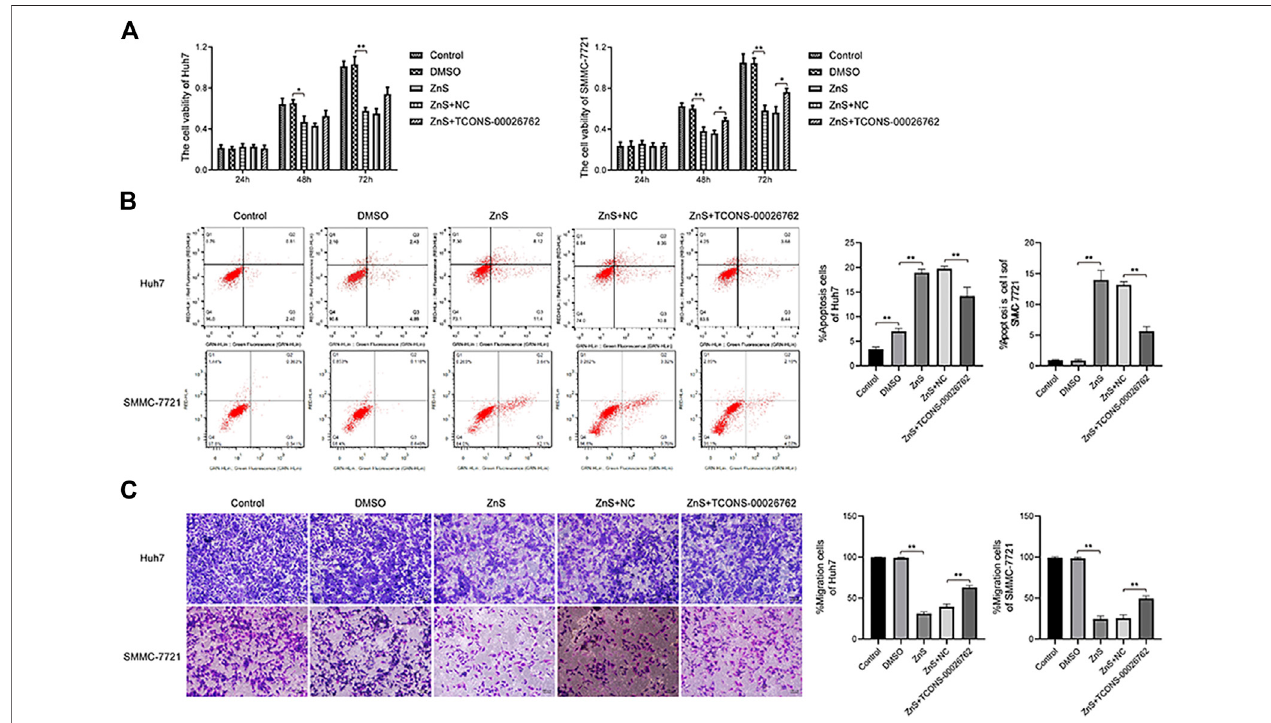
FIGURE3| TCONS-00026,762regulatedthemovabilityofHCCcells. (A) TheviabilityratesofHuh7andSMMC-7721cells. (B) The fl owcytometryanalysisresults and apoptosis rates of Huh7 and SMMC-7721 cells. (C) The invasion of Huh7 and SMMC-7721 cells were detected by transwell. Scale bar, 100 μ m. Each trial was replicated at least three times. Data are expressed as mean ± SD, *, p < 0.05, **, p <